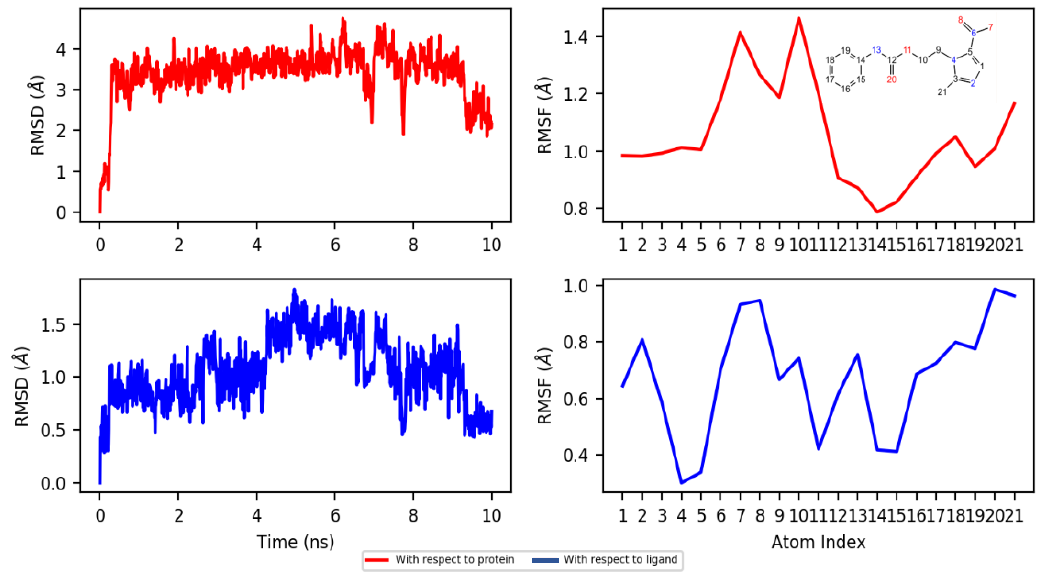
Figure 7. Dynamics of the top pose of compound 2 in the colchicine site of β -tubulin. RMSD (left) and RMSF (right) with respect to protein fit (red) and the initial pose (blue).